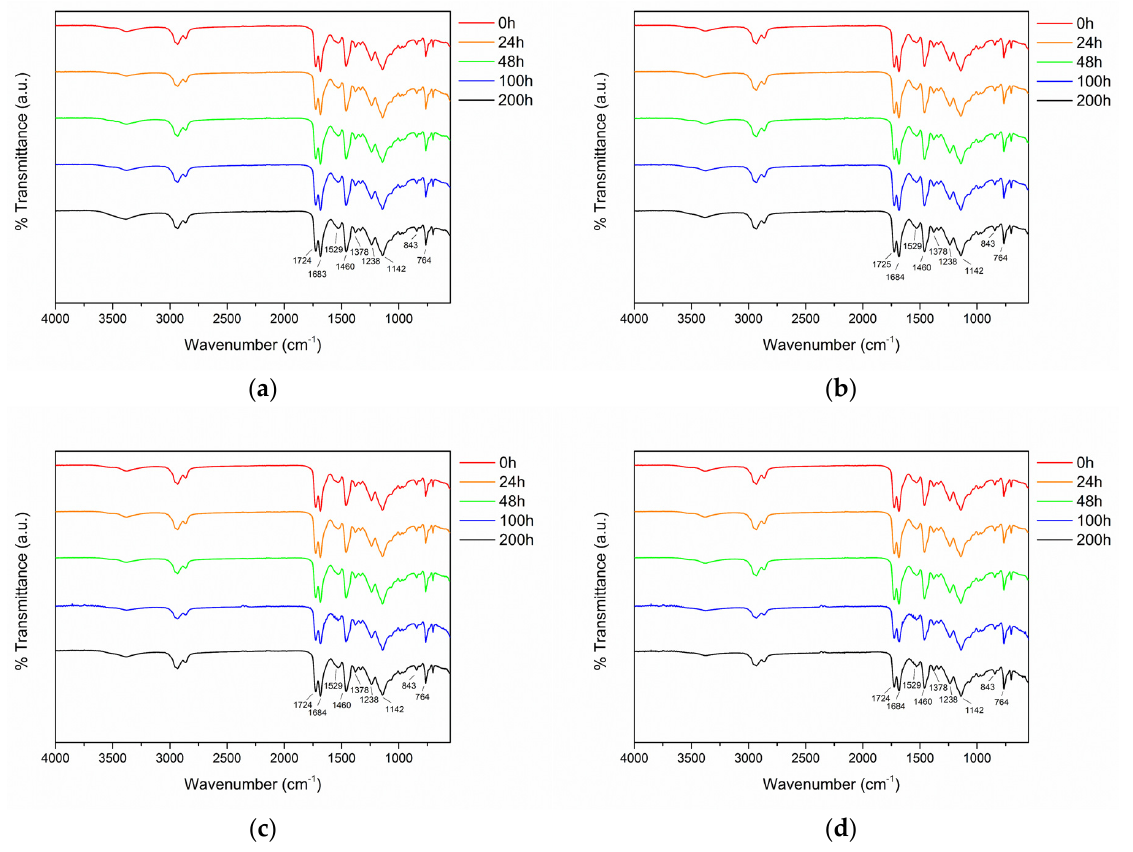
Figure 10. Evolution of the FTIR spectra of ( a ) sample T, ( b ) sample O, ( c ) sample S, and ( d ) sample W, during the exposure to UV-B radiation.